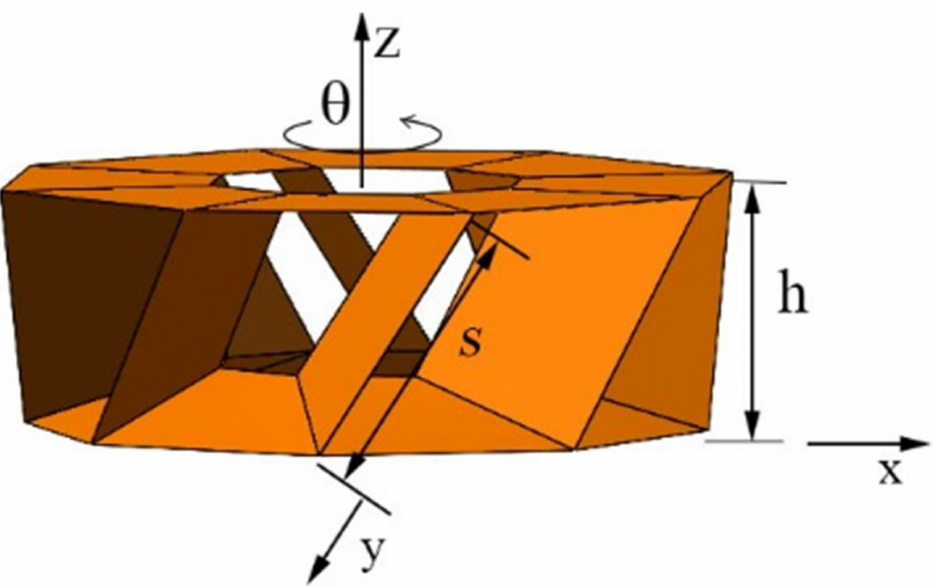
Figure 3. Schematics of axial motion with rotation angle θ